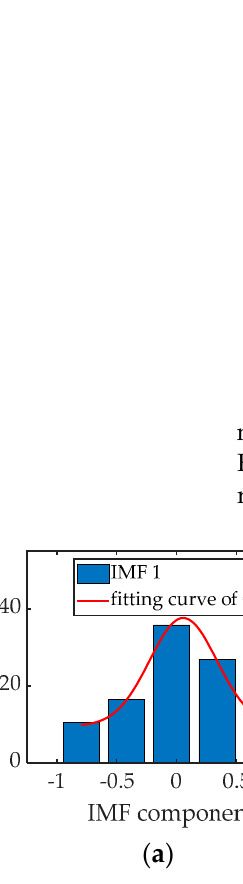
Figure 11. Statistical histogram of the IMF1 and GD-PDF-F curves. ( a ) 50–100 N•m; ( b ) 100–150 N•m; ( c )150–200 N•m.